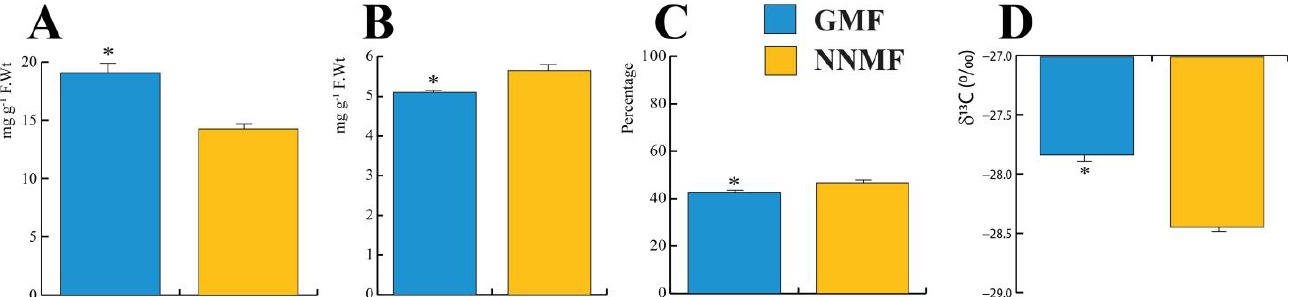
Figure 5. Total carbohydrate, protein, carbon content and δ 13 C of Lima bean plants exposed to the GMF and NNMF. ( A ) Total carbohydrate content; ( B ) total protein content; ( C ) percentage of leaf carbon; and carbon isotope discrimination δ 13 C ( D ). Bars indicate standard deviation, asterisk indicates significant ( p < 0.05) differences between GMF and